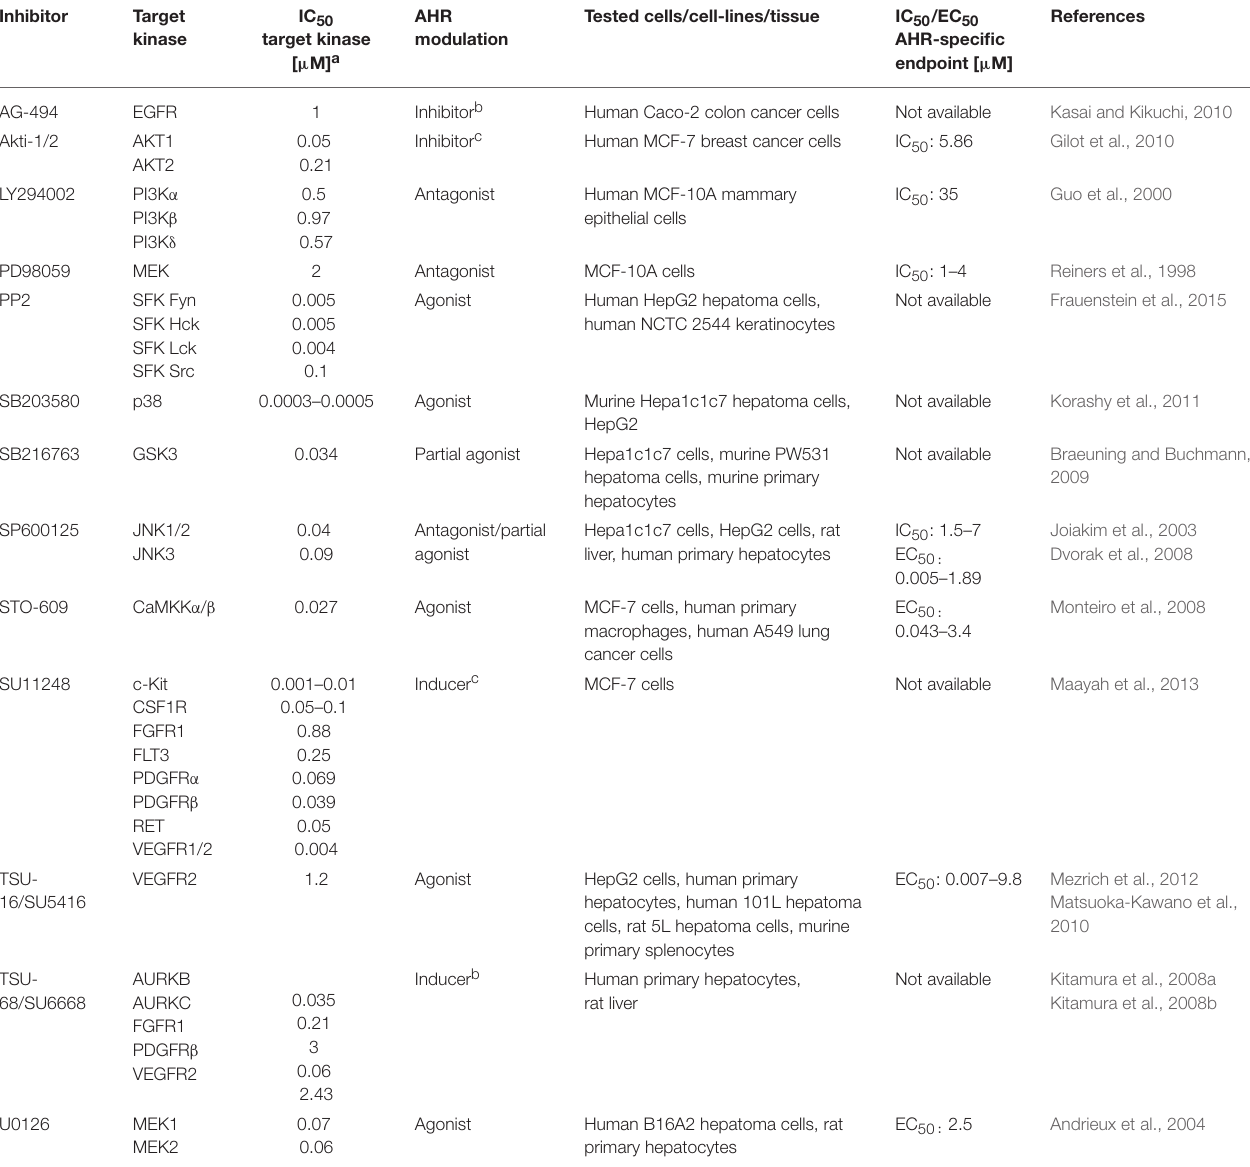
TABLE 1 | Overview on protein kinase inhibitors known to manipulate AHR signaling. Inhibitor Target kinase